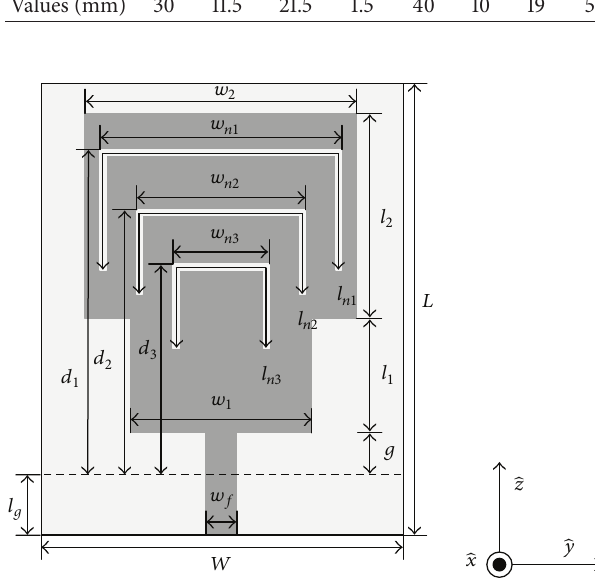
Figure 1: Geometry of the proposed multiband